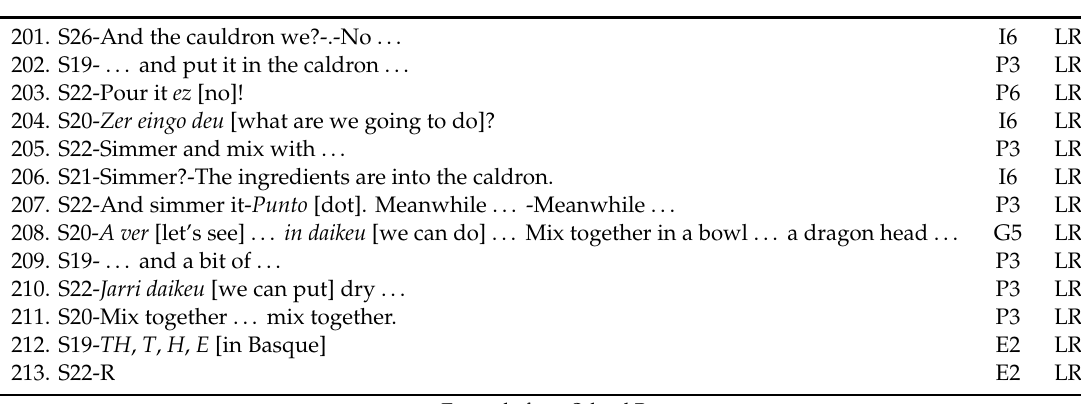
Table 8. Example from School